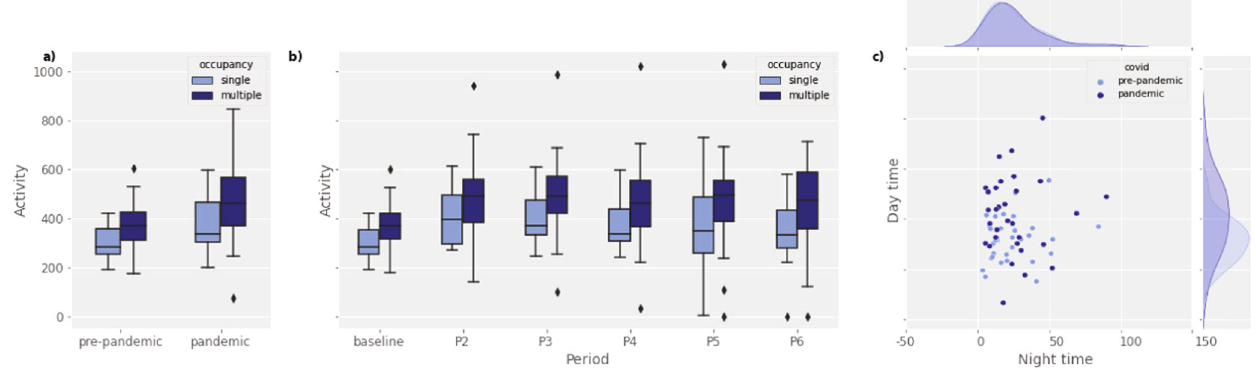
Fig. 3 Changes in mean daily activity (sensor triggers) level during COVID-19. a Mean daily activity across households according to occupancy before and during COVID-19 (boxplot shows the minima and maxima values, lower and upper quartiles, and the medians); b Mean daily activity across households according to occupancy during the different pandemic periods (boxplot shows the minima and maxima values, lower and upper quartiles, and the medians) and c Distribution of mean daily activity across households during day and night before and during